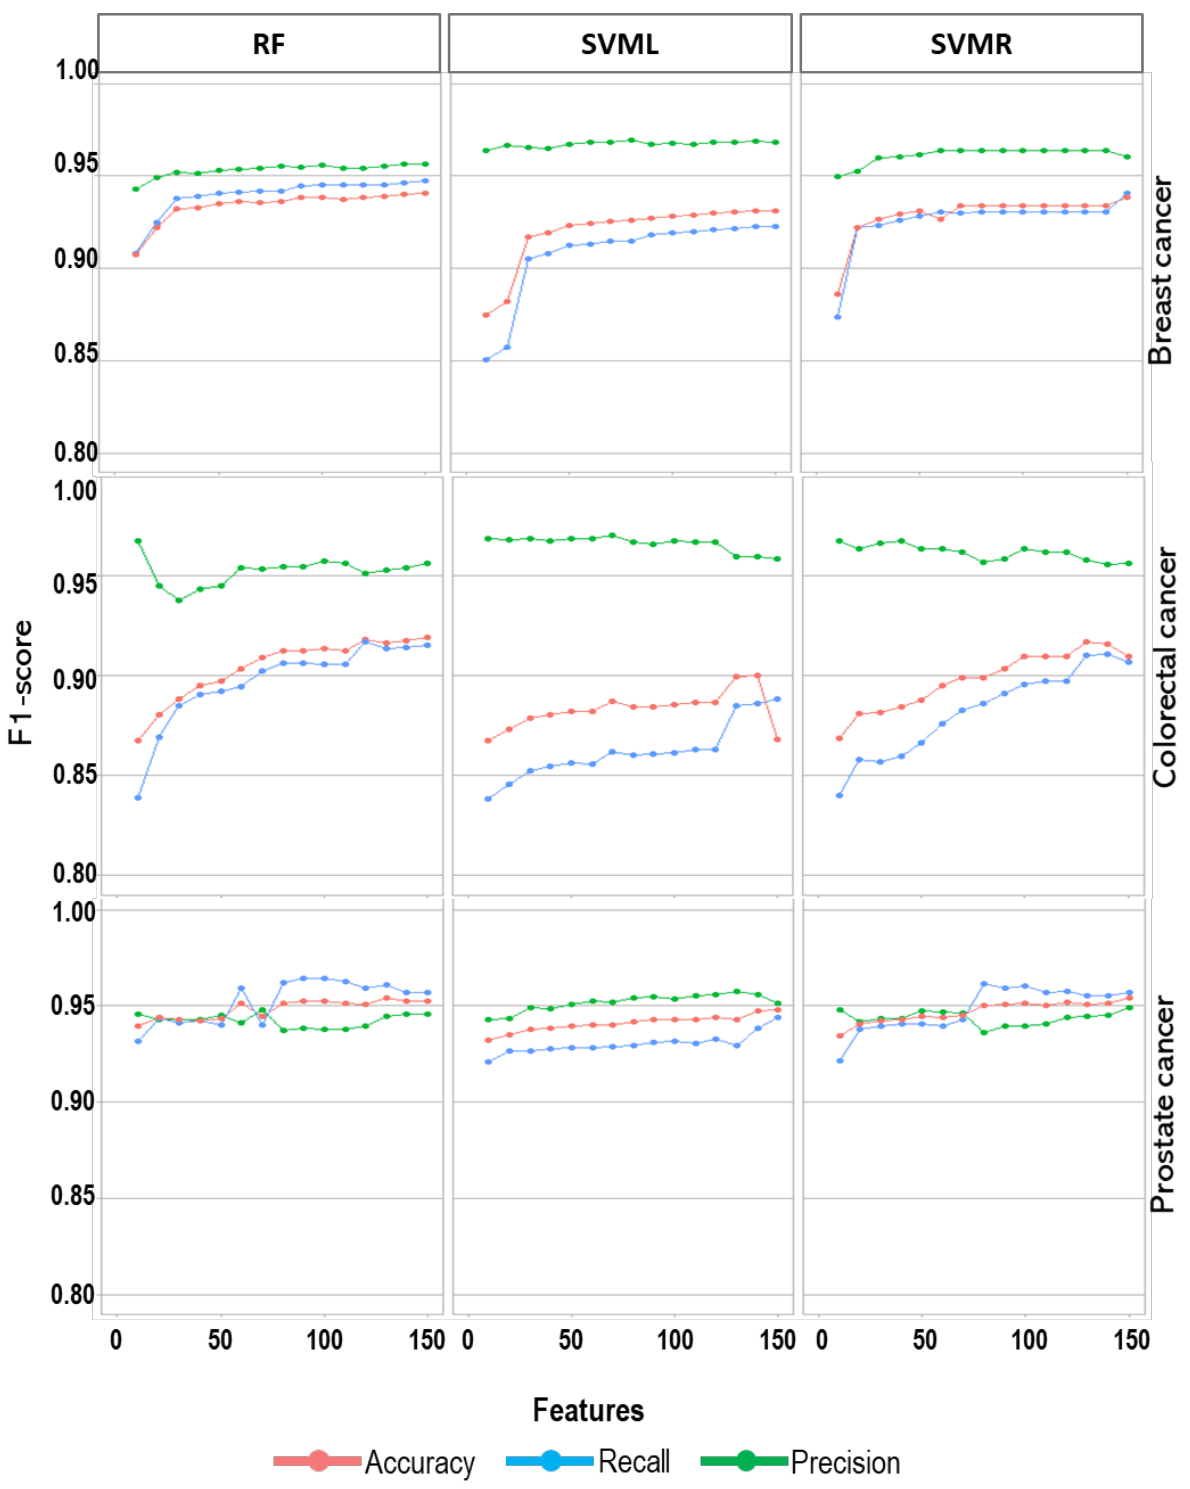
Figure 8. Precision, recall, and accuracy measure of the classifiers over the feature sizes for each cancer type. The figure shows different patterns in each evaluation metric across the feature sizes and for each cancer